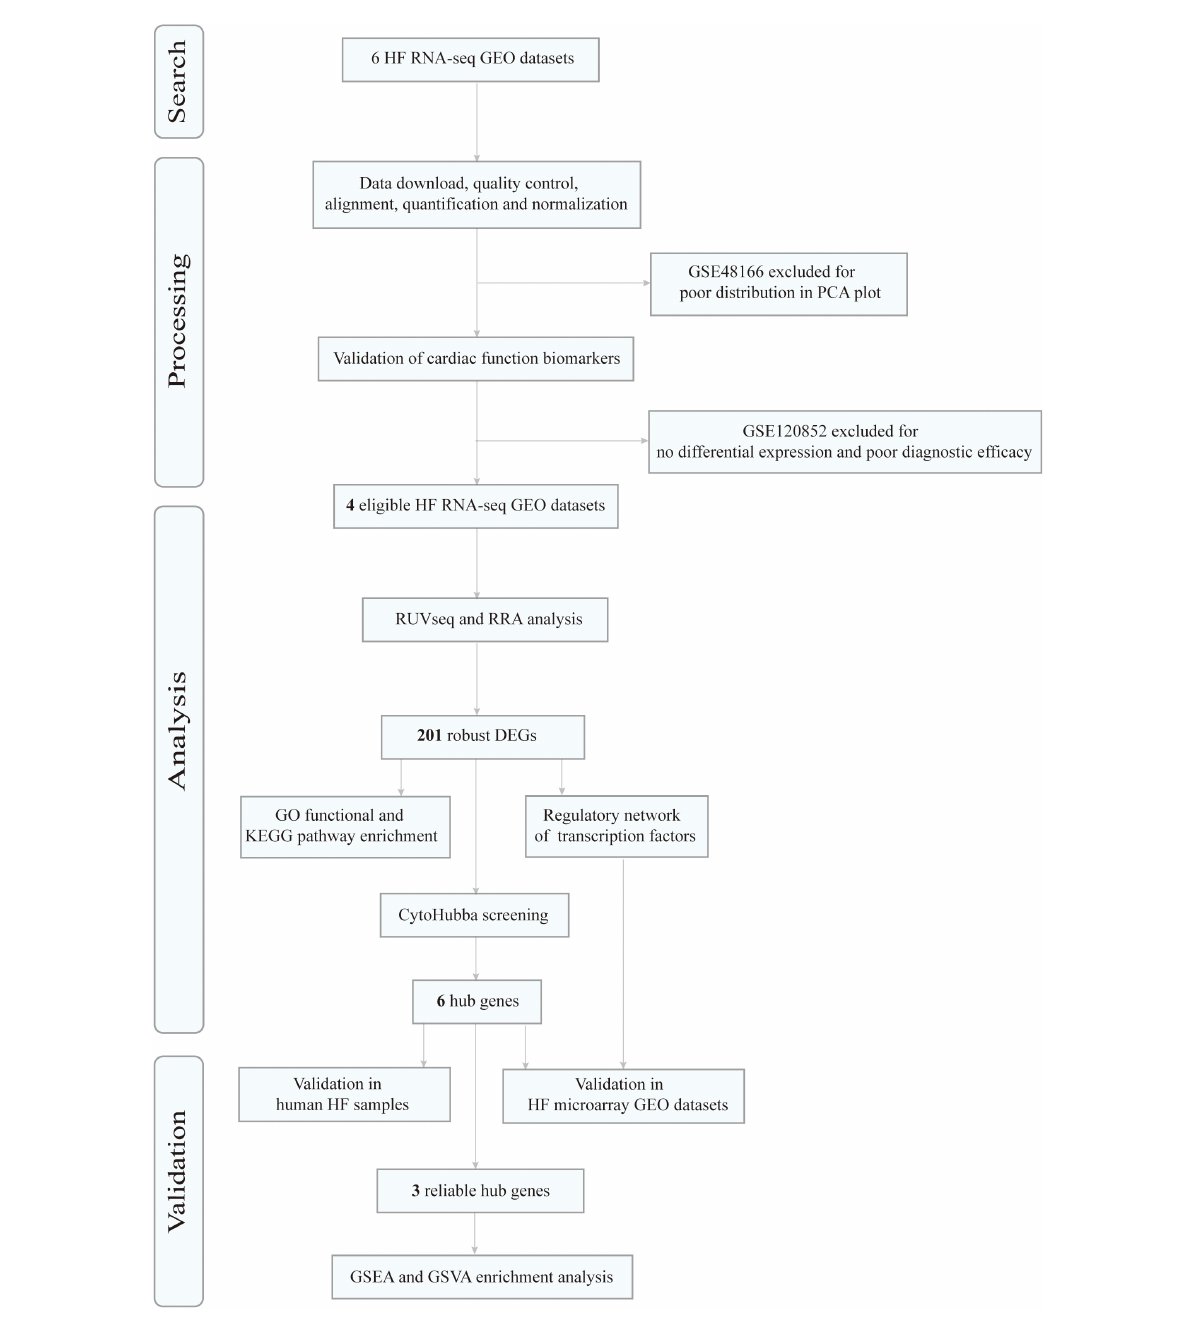
FIGURE1 Flowchart of data search, processing, analysis, and validation. HF, heart failure; RNA-seq, RNA sequencing; GEO, Gene Expression Omnibus; PCA, principal component analysis; RRA, robust rank aggregation; DEGs, differentially expressed genes; GO, gene ontology; KEGG, Kyoto Encyclopedia of Genes and Genomes; GSEA, gene set enrichment analysis; GSVA, gene set variation